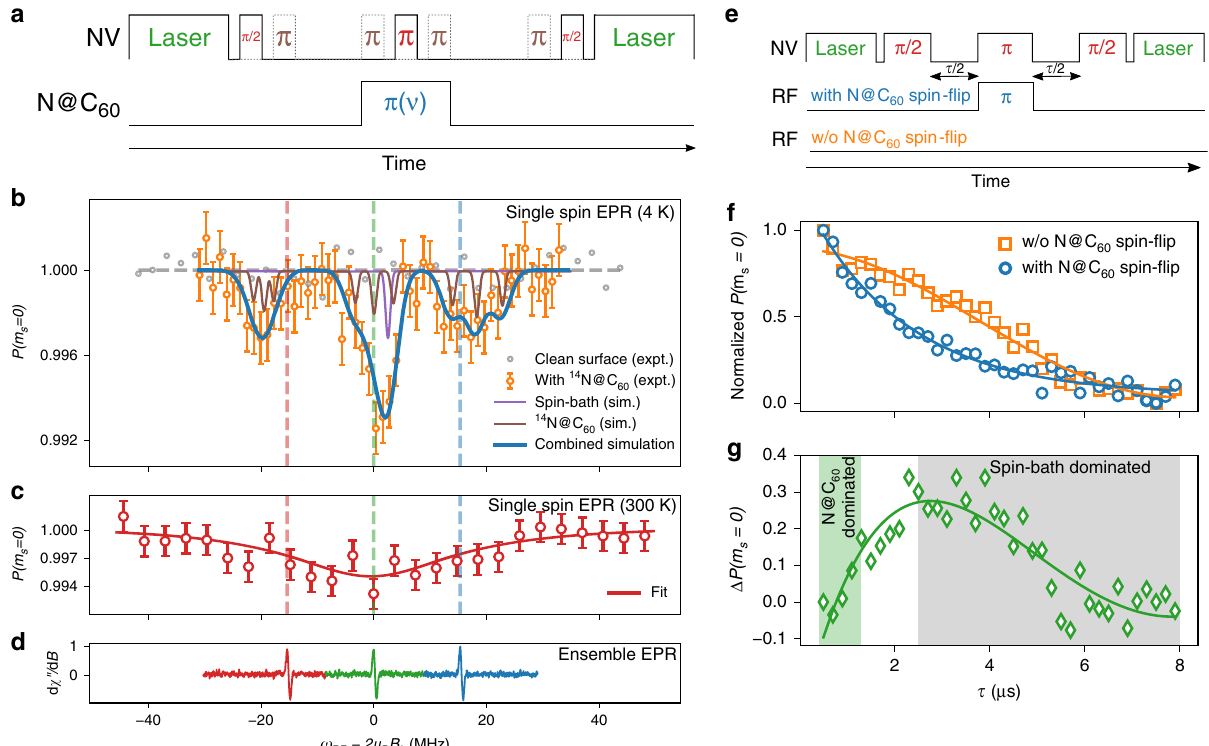
Fig. 2 Electron spin resonance of endofullerenes. a Single-spin electron paramagnetic resonance (EPR) realized using double electron – electron resonance (DEER) in the double-quantum (DQ) basis. Brown pulses (dotted lines) and red pulses (continuous lines) address 0 → + 1 and 0 → − 1 nitrogen vacancy (NV) transitions, respectively. b Low-temperature DEER-DQ spectroscopy on a single NV center in diamond. The solid brown and purple lines indicate the simulated spectrum of a single N@C 60 , and weakly coupled spin-bath ( g = 2.03), respectively (linewidths reduced to 1 MHz for clarity). The solid blue line indicates the combined simulation with experimental linewidth. The simulated endofullerene has an isotropic hyper fi ne constant a = 19 MHz, axial zero- fi eld splitting D = 1.52 MHz and a static magnetic fi eld B = 9.697 mT (see Supplementary Section 2). Dotted vertical lines indicate positions of ensemble 0 EPR hyper fi ne components. Error bars depict photon shot noise. c Spectrum decays under room-temperature (RT) thermo-optical load, solid line indicates fi t to single Lorentzian model. Dotted lines indicate positions of ensemble EPR hyper fi ne components. Error bars depict photon shot noise. d Ensemble solution EPR data on the same N@C 60 sample measured across ∼ 10 9 spins. e Pulse sequence comparing NV center Hahn-echo decoherence in presence ( fi rst RF sequence) and absence (second RF sequence) of an RF spin- fl ip on N@C 60 . f Direct comparison of the temporal evolution of the NV Hahn-echo signal with and without a spin- fl ip on the coupled N@C 60 . g Difference in NV center decoherence at short evolution times versus longer evolution times reveals the clear separation of timescales at which the NV – N@C 60 interaction is